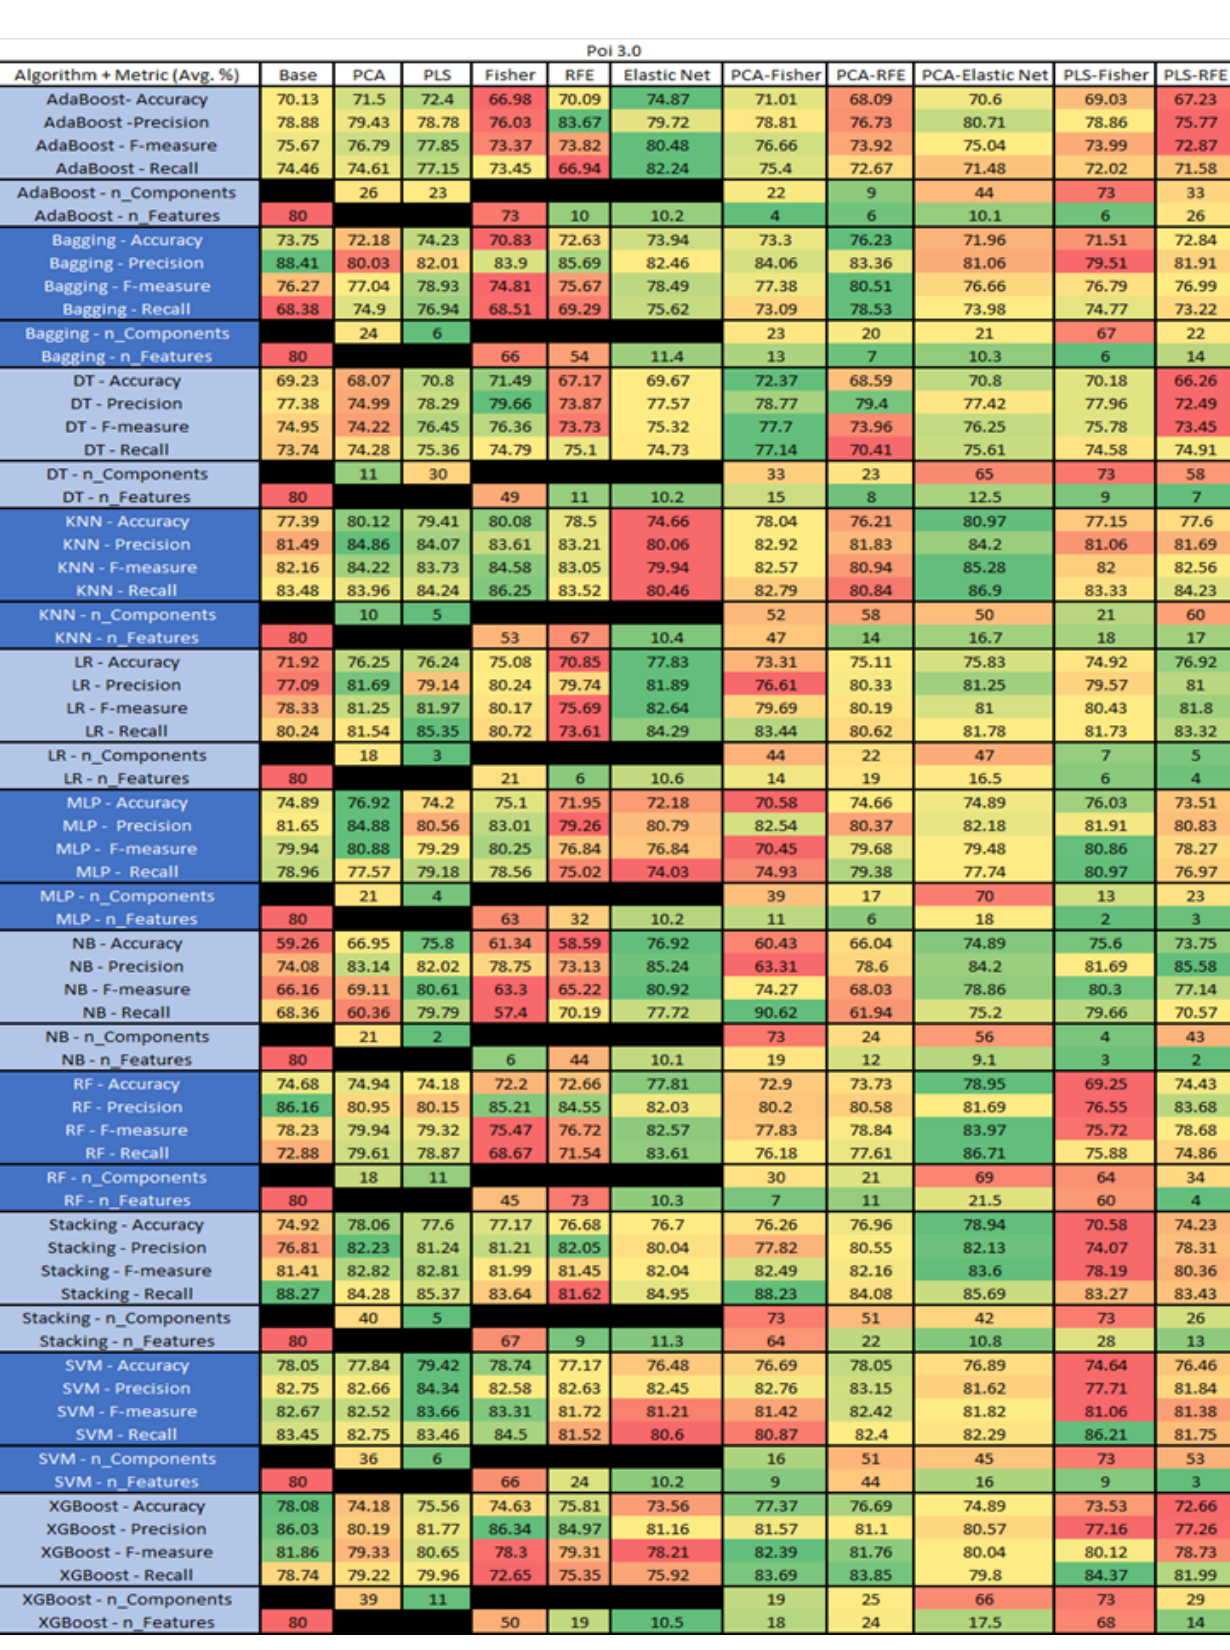
Figure 50. Poi 3.0 PROMISE Results Data